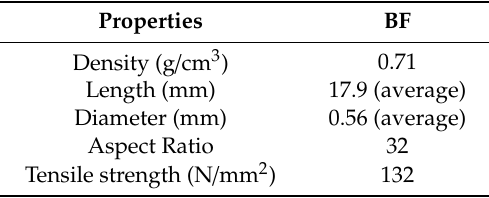
Table 3. Characteristics of the bagasse fibers.